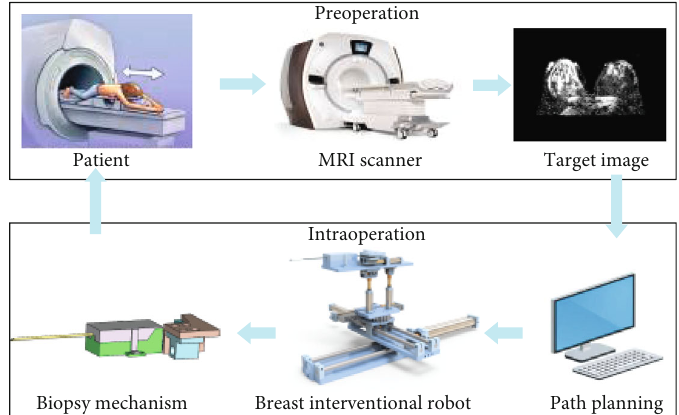
Figure 2: The overall structure of the breast intervention robot system.